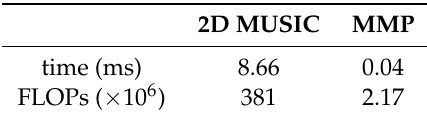
Table 3. The required number of floating point operations in a single